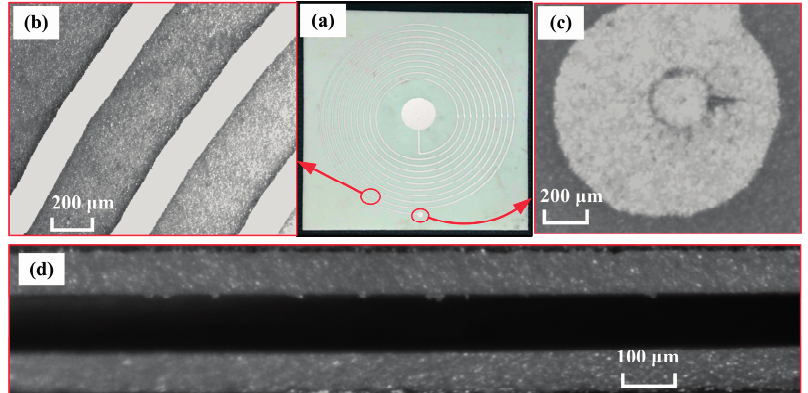
Figure 6. ( a ) Photograph of the fabricated sensor ( b ) photomicrographs of the inductance coil; ( c ) via; and ( d ) capacitor